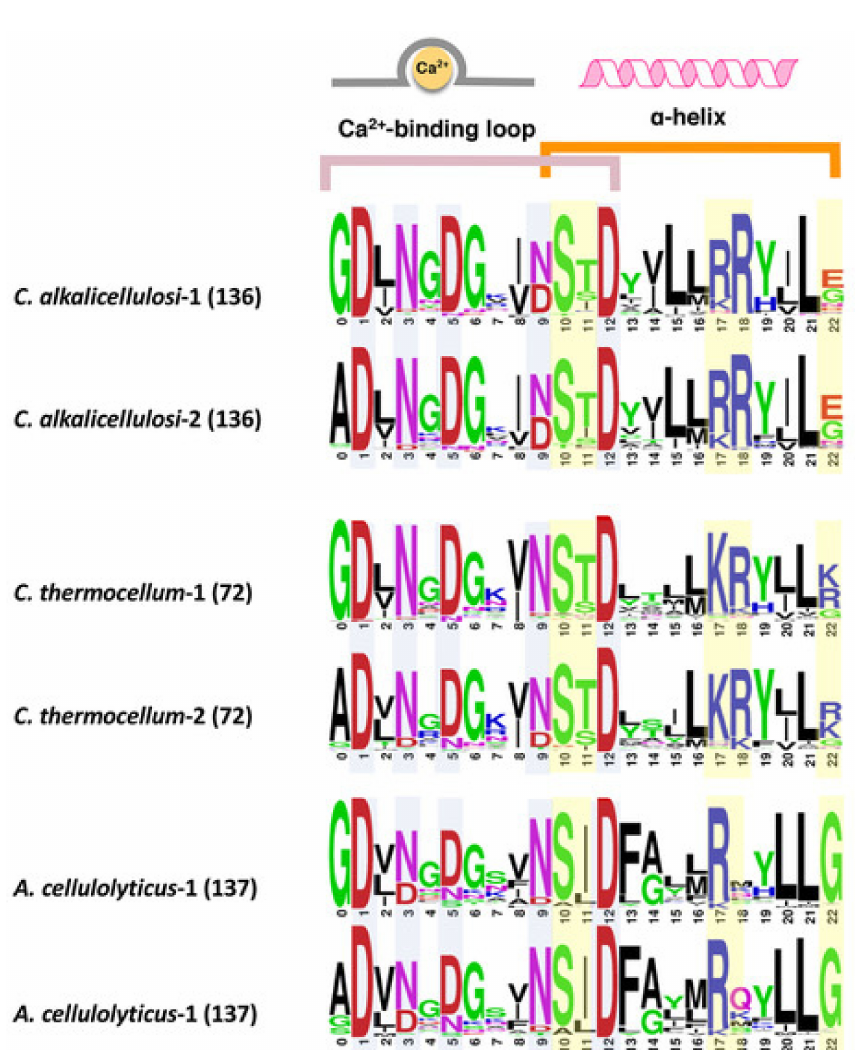
Figure 3. Comparison of conserved type I dockerin sequences of C. alkalicellulosi , C. thermocellum , and A. cellulolyticus . Each sequence shows the repeated segments (1 and 2) of dockerin sequences. Light blue and yellow colors highlight potential residues responsible for calcium binding and recognition sites for cohesin–dockerin interaction, respectively. The number in the bracket represents the numbers of sequences in the given species used for creating alignment in